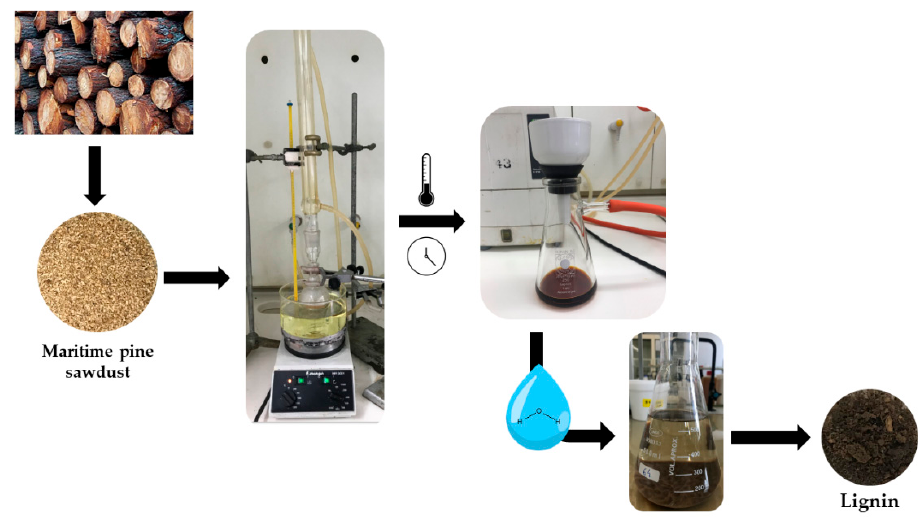
Figure 2. Experimental scheme for lignin extraction.